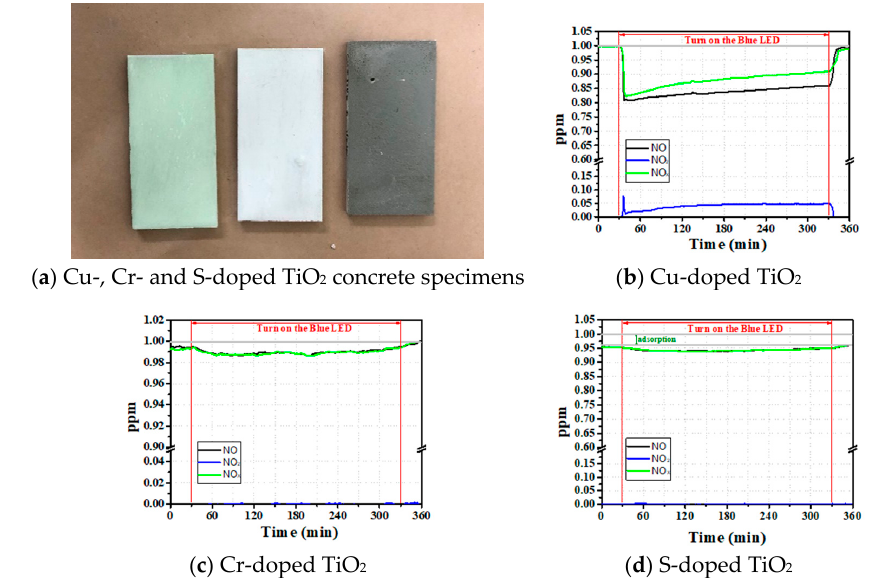
Figure 15. Doped TiO 2 concrete specimens and photocatalytic NO removal performance test of